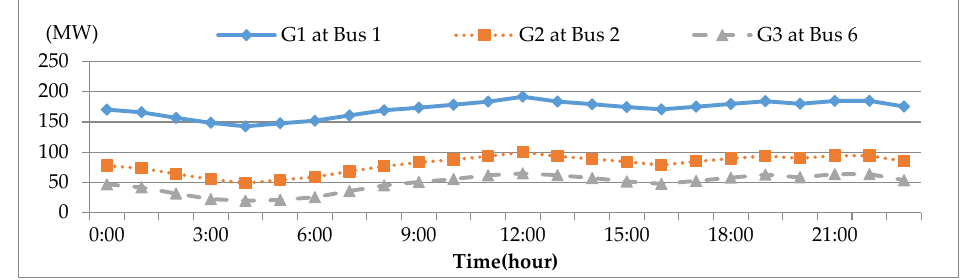
Figure 8. Electricity purchased/sold cost of MG-A.